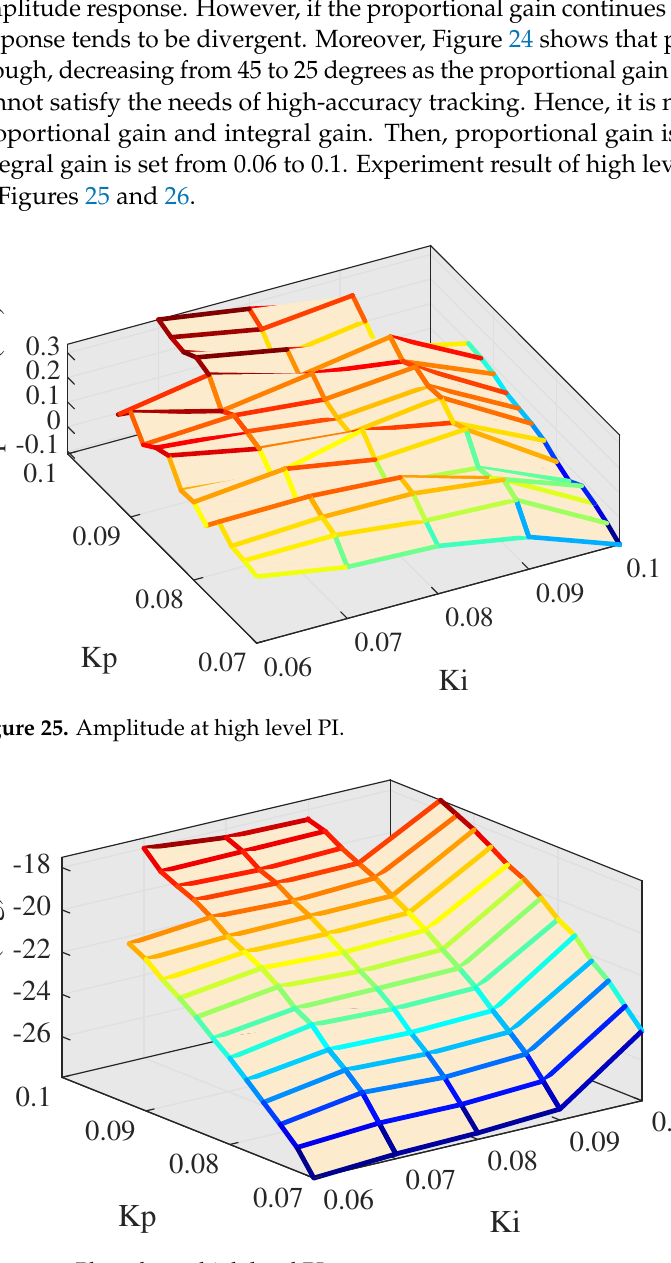
Figure 26. Phase lag at high level